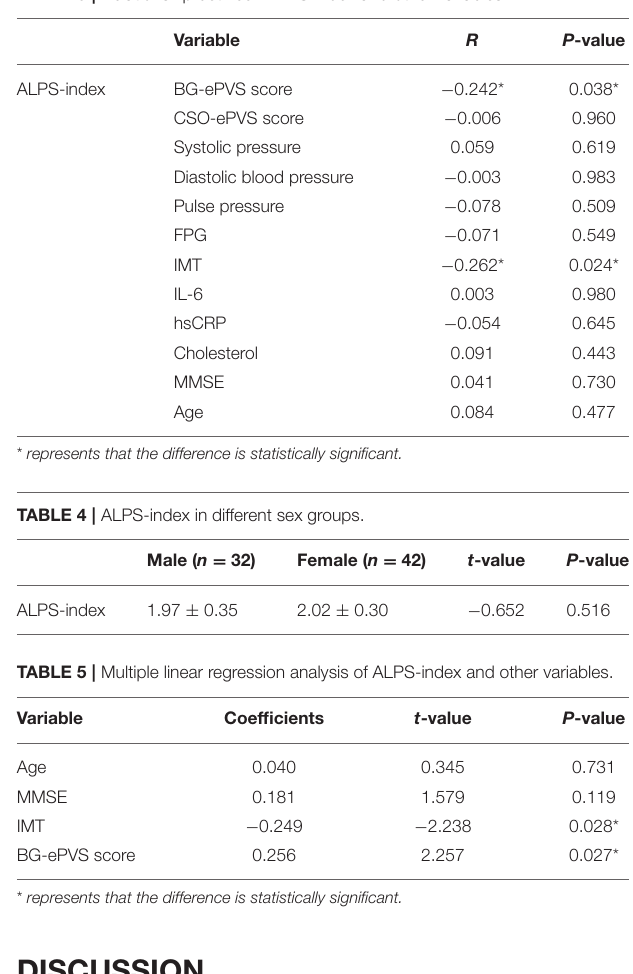
TABLE 3 | Relationship between ALPS-index and other variables.